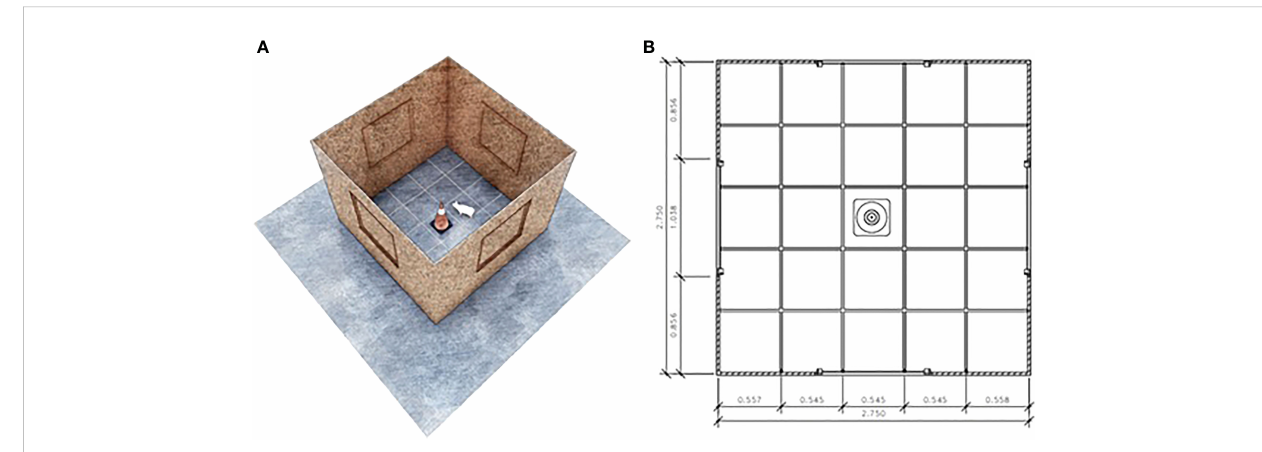
FIGURE 2 Open fi eld and Novel object test arena (A) . The test arena measured 2.75 m x 2.75 m and had markings along the fl oor dividing the area into 25 similar quadrants (B) .